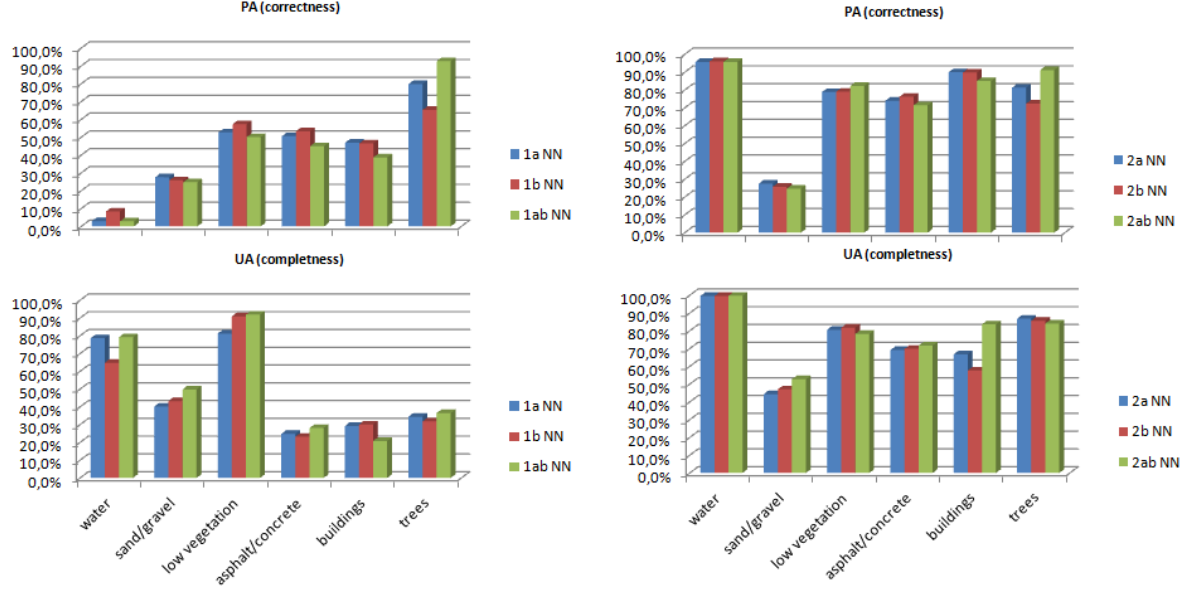
Figure 7. Producer’s and User’s accuracy of land cover/use classification for approaches using first (a), last (b) and both: first and last (ab) echo number of laser beams from multispectral ALS data, during intensity raster creation approaches using spectral classification of ALS intensity rasters (variants of Approach 1) supported by the nDSM (variants of Approach